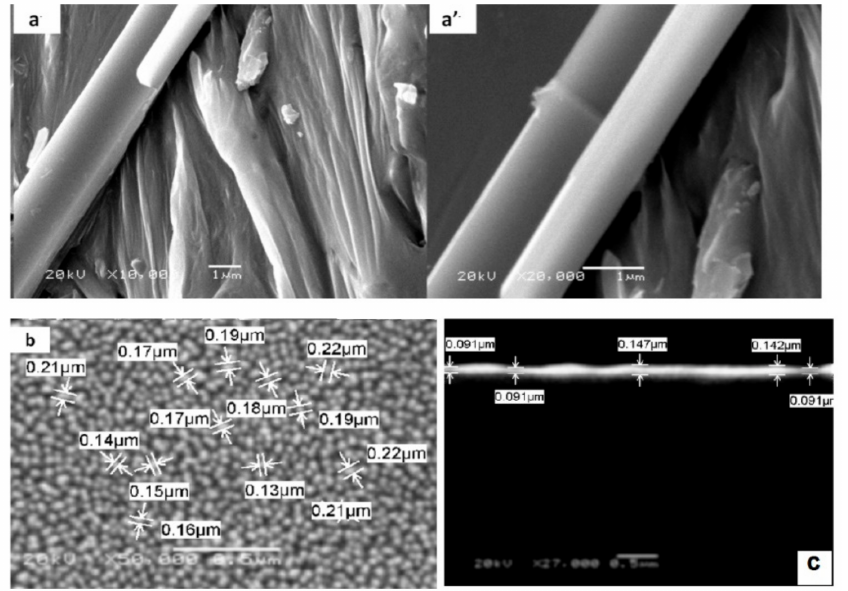
Figure 3. FESEM of GaN; ( a,a’ ) bulk alloy, ( b ) thin film, and ( c ) cross-section area of the thin